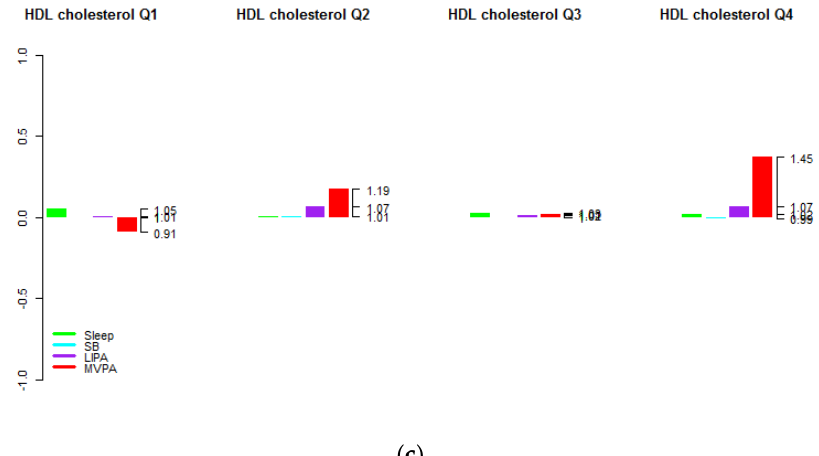
Figure 2. Average time-use compositions of the 24-h day by health indicator quartiles for older adults aged (65–79) for ( a ) BMI, ( b )Aerobic fitness and ( c ) HDL cholesterol level (in log-ratio scale and relative to the overall average time-use composition at the zero baseline). The left axis gives the log-ratio value and the right axis gives the actual proportion relative to the mean composition (e.g., 1.45 means 1.45 times the compositional mean or a proportion higher by 45%).